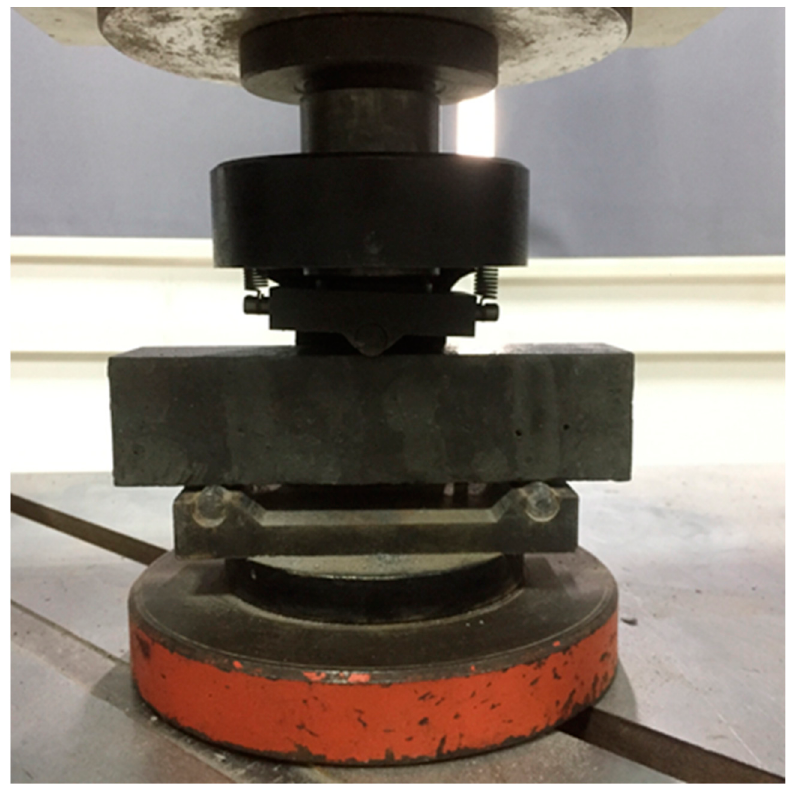
Figure 3. Test set-up for flexural strength test.